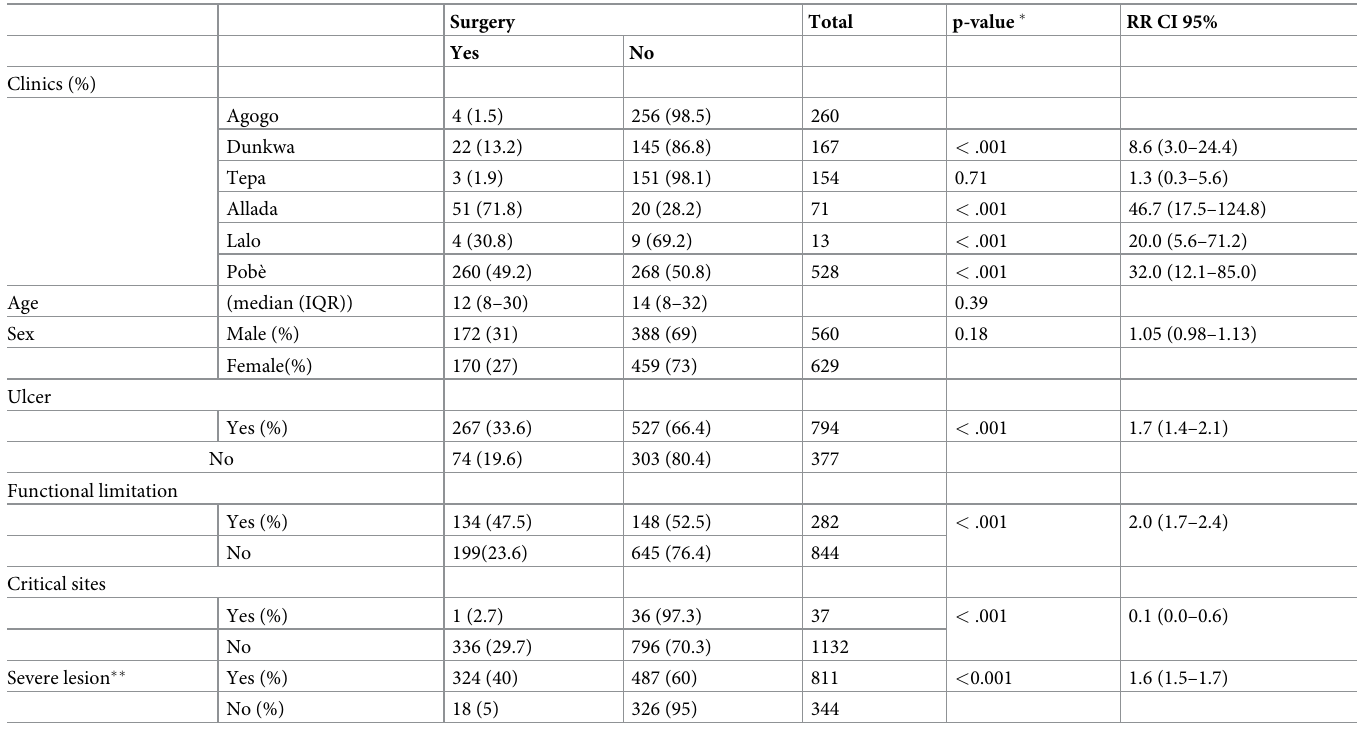
Table 2. Differences in surgical practice between clinics and patient characteristics.